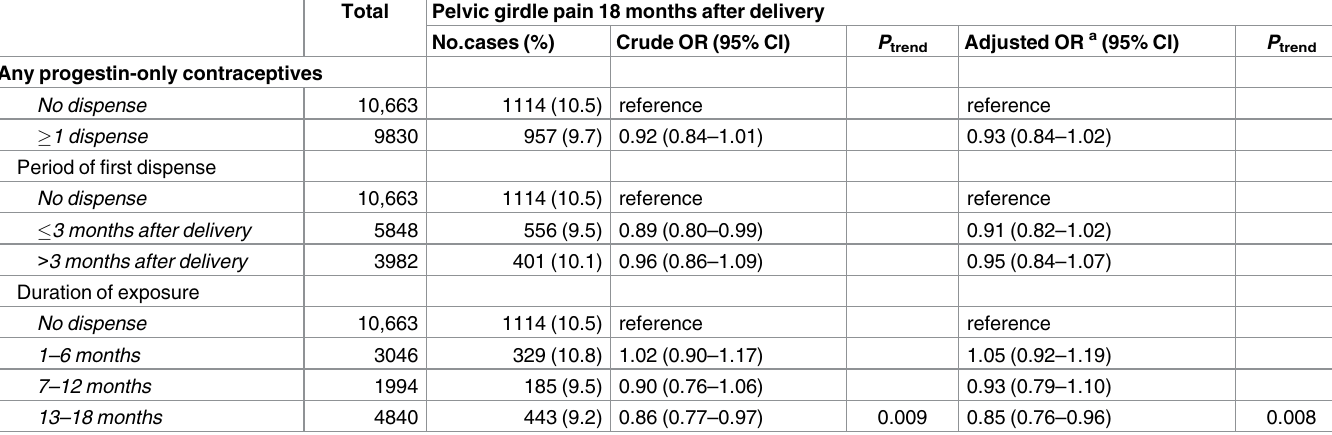
Table 2. Associations of any progestin-only contraceptives and pelvic girdle pain 18 months after delivery (N =